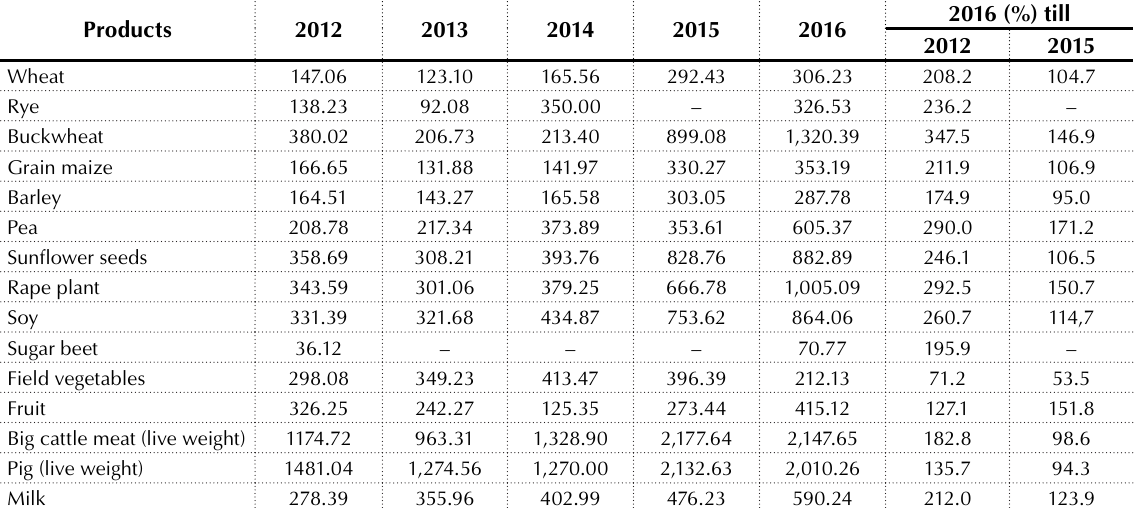
Table 3. Selling price dynamics for products of agricultural enterprises of Khrystynivka district, Cherkasy region, UAH per 1 centner